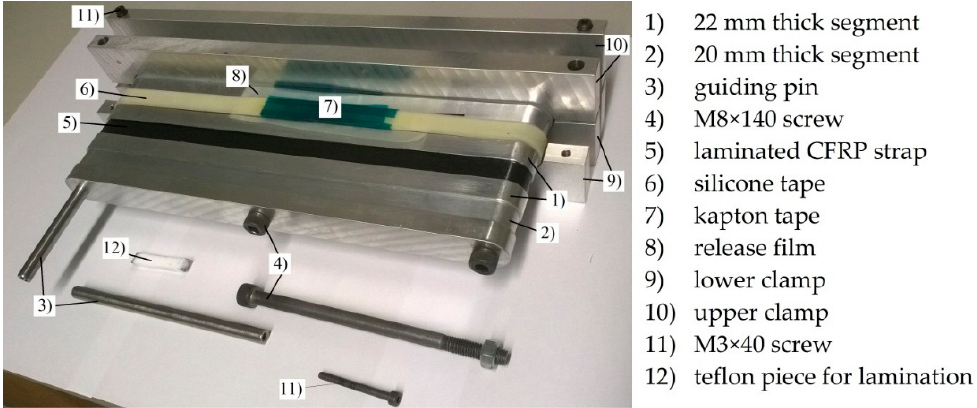
Figure 2. Mould for lamination of the CFRP straps.